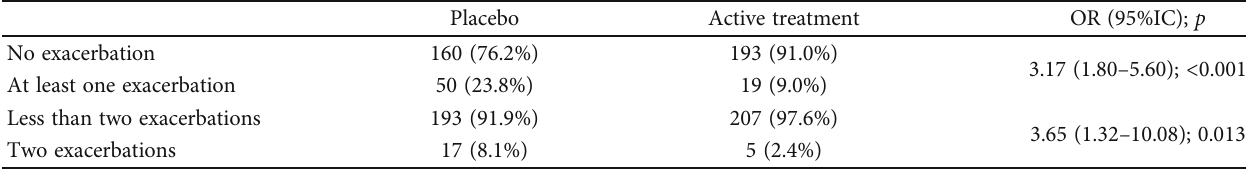
Table 2: Number and frequency of children with or without asthma exacerbations during the study.